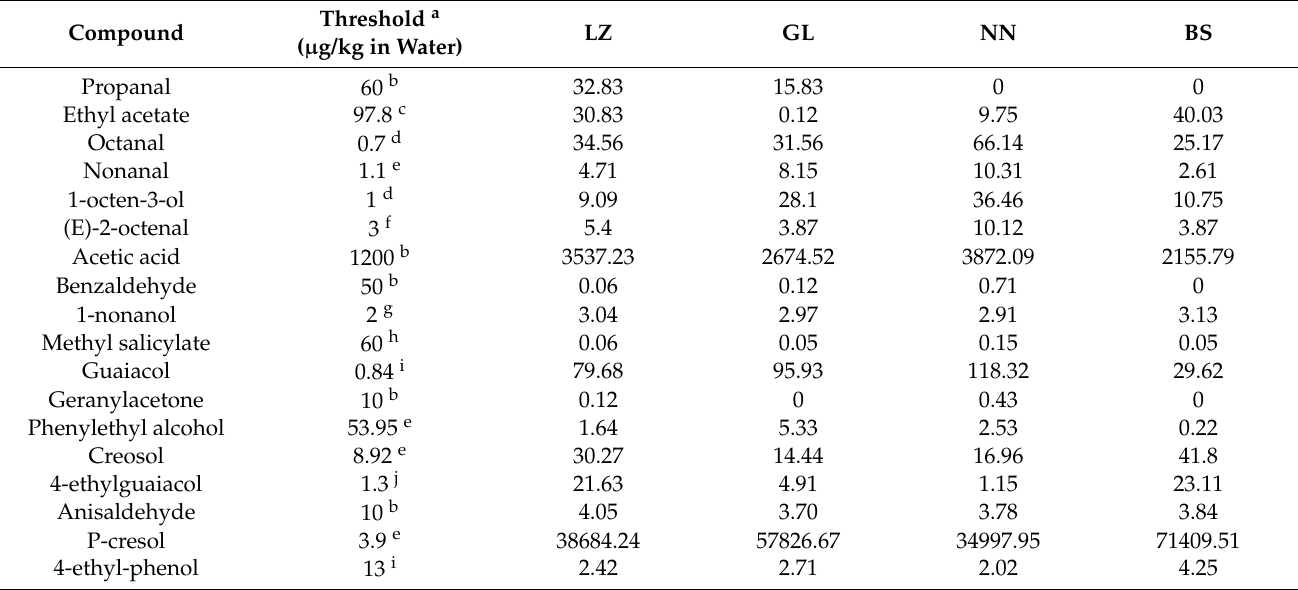
Table 3. Aroma compound OAVs calibrated by standard